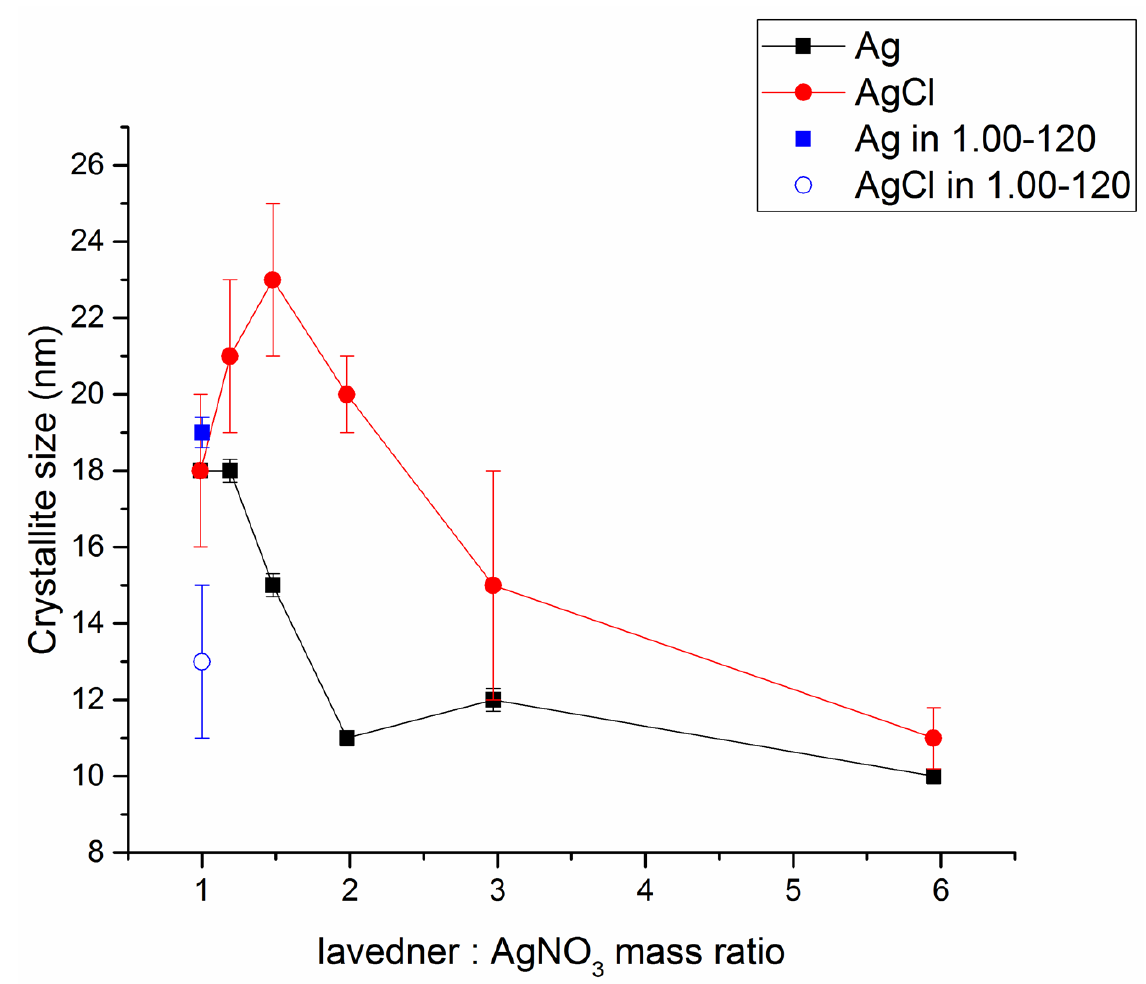
Figure 3. Changes in crystallite size of Ag and AgCl with the lavender:AgNO 3 ratio in all LEV-Ag-MSW samples.